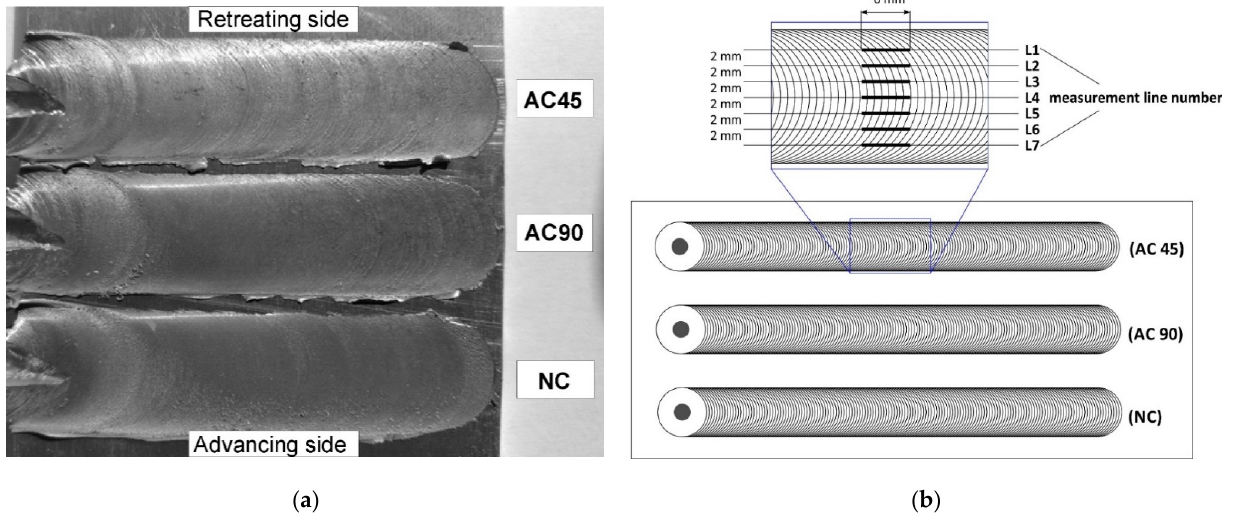
Figure 4. Macroscopic effect of FSP ( a ), scheme for measuring surface roughness of bands ( b ). The obtained values of the individual roughness parameters as a function of the measuring line location are shown in Figure 5, and the mean values of the Ra, Rz, Rc parameters together with the calculated confidence intervals are given in Table 3.